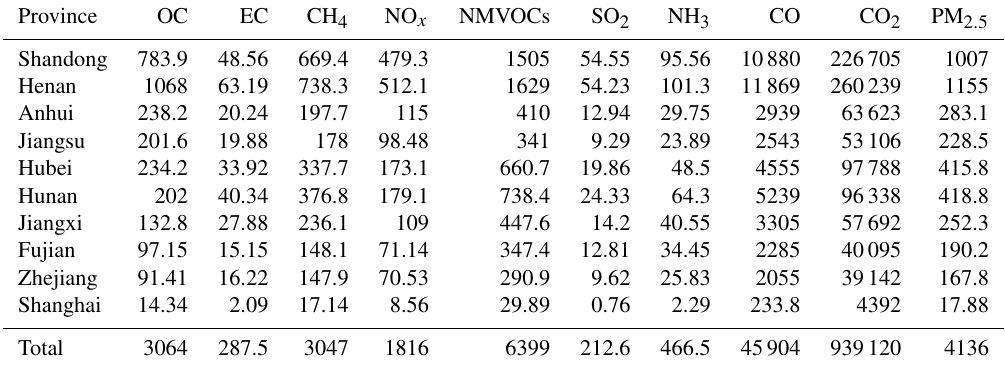
Table 5. The emission factors of open biomass burning emissions for various pollutants (gkg − 1 dry matter). Vegetation OC EC CO CH 4 NO x NMVOCs SO 2 NH 3 PM 2 . 5 Corn Rice Cotton Soy bean Sugar cane Peanut Potato Tobacco Sesame Sugar beet Broadleaf forest Mixed forest Grassland